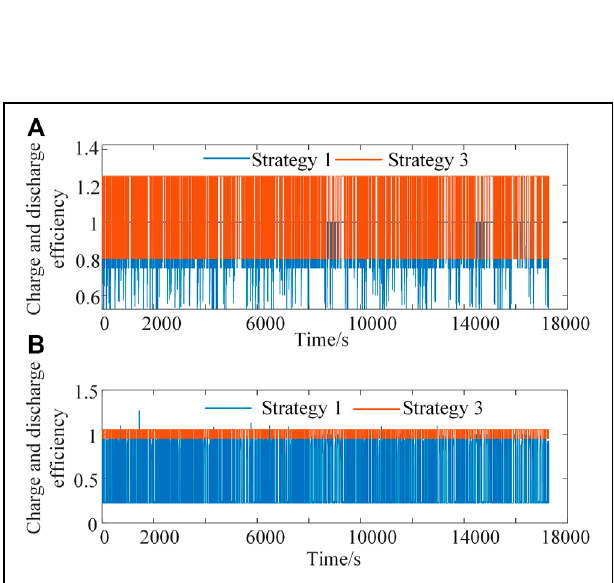
FIGURE 8 | Charge–discharge efficiency of strategy 1 and strategy 3. (A) Charge and discharge efficiency of battery. (B) Charge and discharge efficiency of